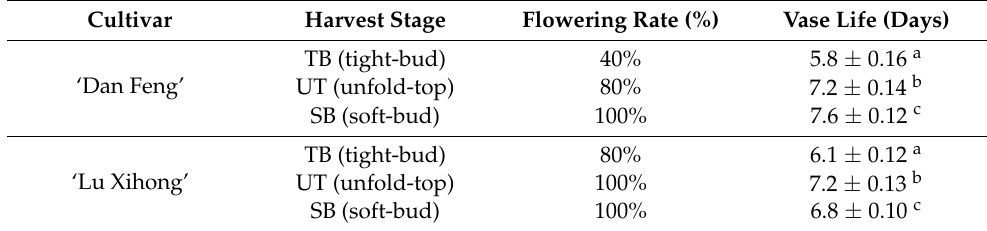
Table 1. Effects of harvesting stage on flowering rate and vase life of “open-top type” cut P. lactiflora .